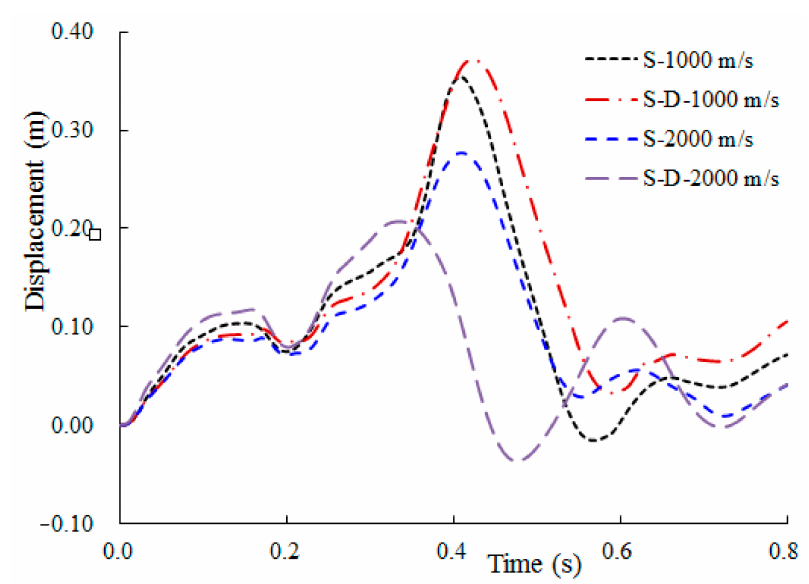
Figure 14. The internal energy time-histories of concrete.